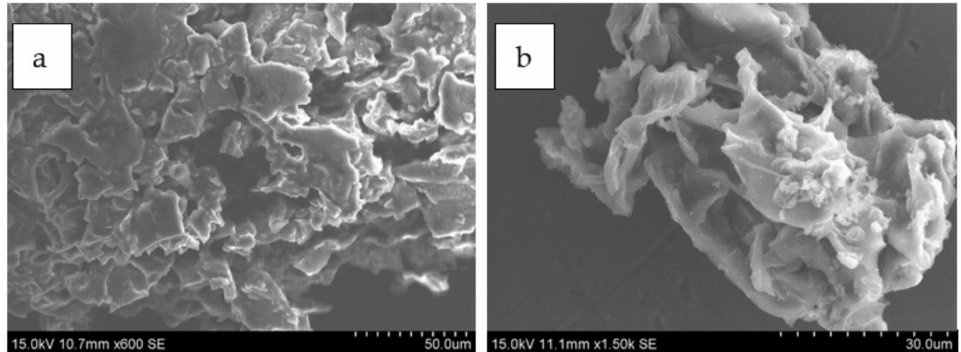
Figure 13. SEM micrographs of spent ( a ) coffee grounds (SCGs) and ( b ) transformed-spent coffee grounds